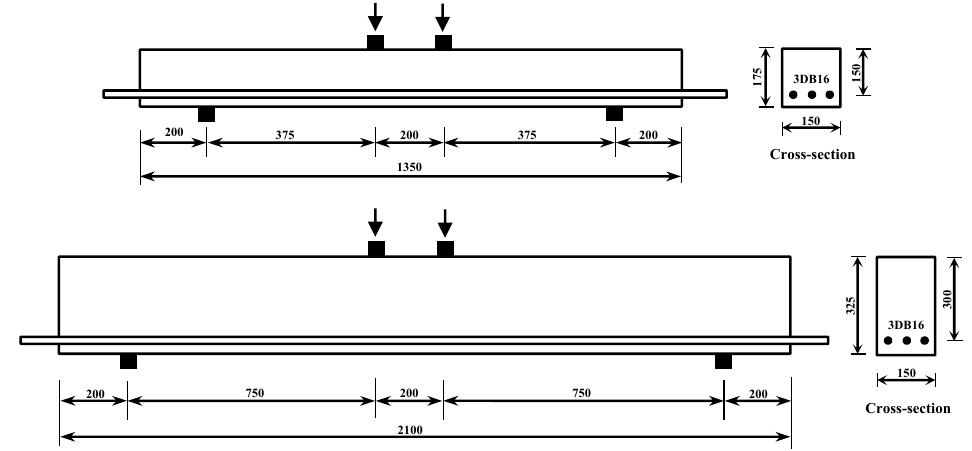
Figure 2. Specimen dimensions and loading points for the shear testing (unit: mm).